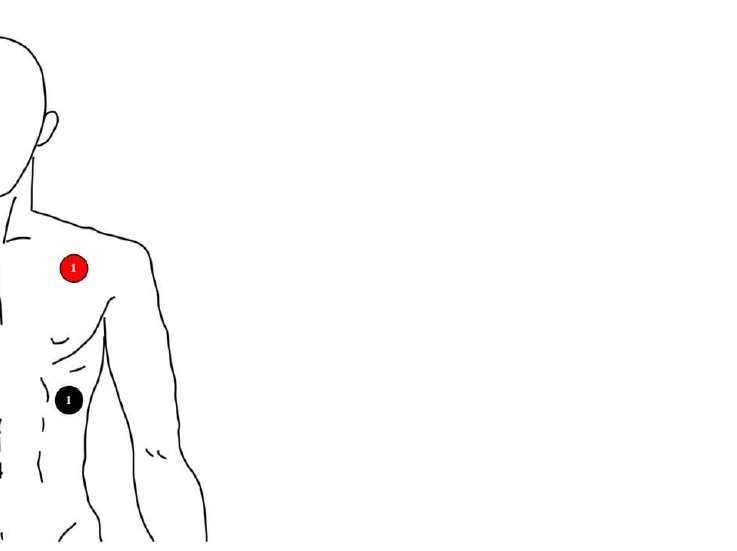
Figure 1. Schematic illustration of the configuration of ECG leads. The numbers of the electrodes correspond to each channel. The grey color stands for the negative electrode, the red color stands for the positive electrode, and the black color stands for the reference electrode. Channel 1 records the ECG (electrocardiography) from the negative electrode in the right subclavian area to the positive electrode in the left, and the reference electrode is placed in the left abdomen area. The signal is transformed to SKNA (skin nerve activity)-Chest via computer software. Channel 2 records the SKNA from the right arm to avoid ECG contamination.